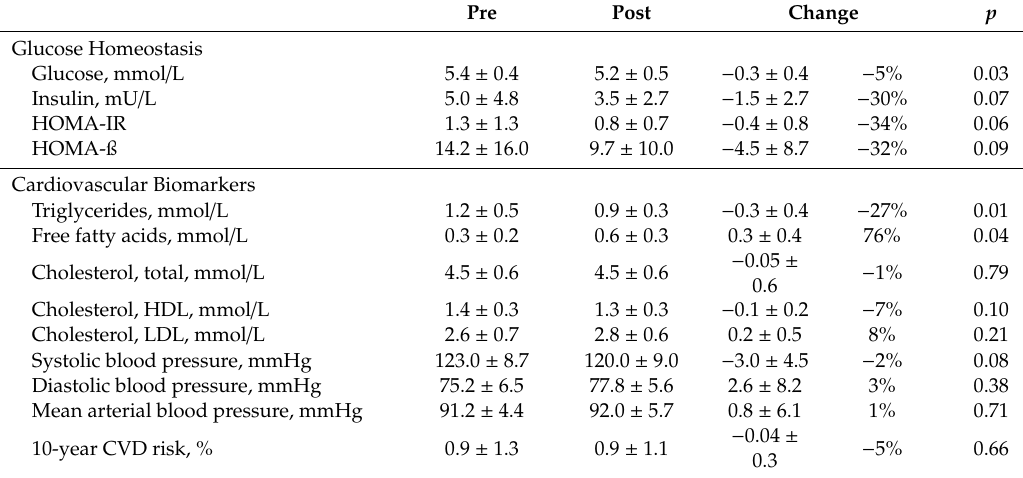
Table 1. Cardiometabolic risk